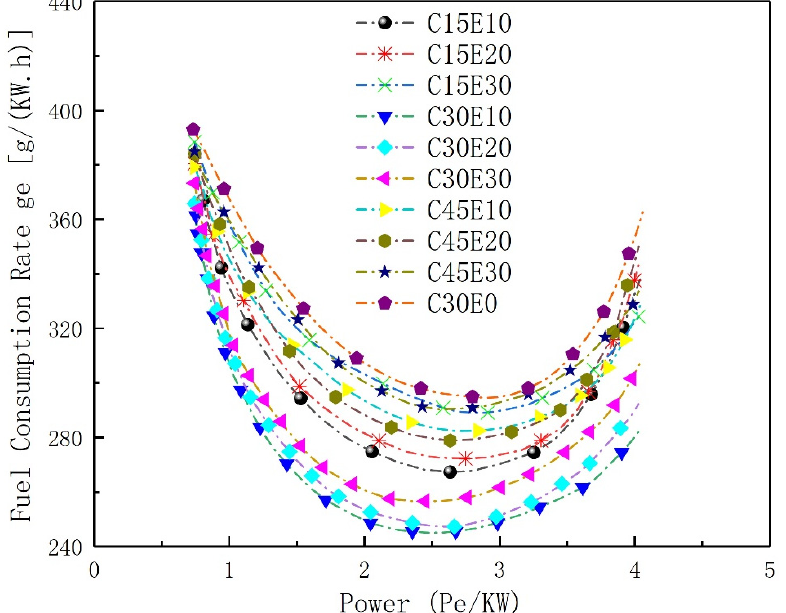
Figure 9. Load characteristics of all swirl chamber diesel engine schemes at the rotation speed of 2400 r/min. Note: the scheme numbers are the same as those in Table 1.